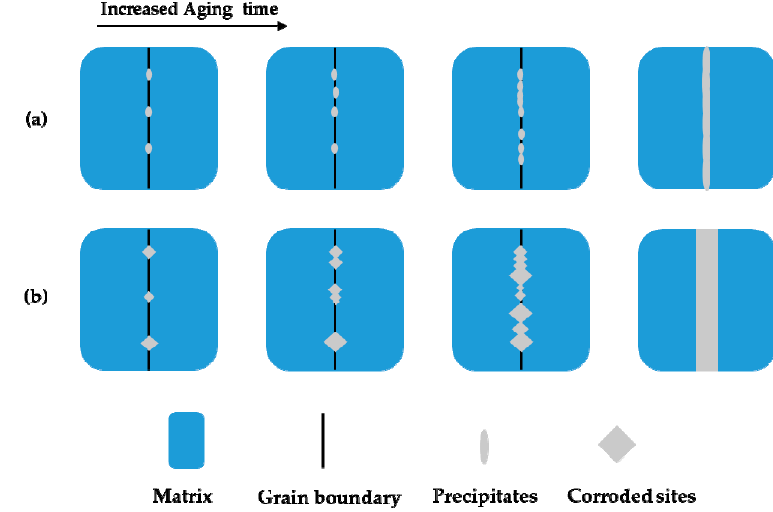
Figure 8. A schematic diagram for the initiation and growth of precipitates and intergranular corrosion with the extended aging time for the aged Cr–Mn–Ni–N–Cu austenitic stainless steel sample: ( a ) The growth of precipitates; ( b ) the growth of crystallographic intergranular corrosion.